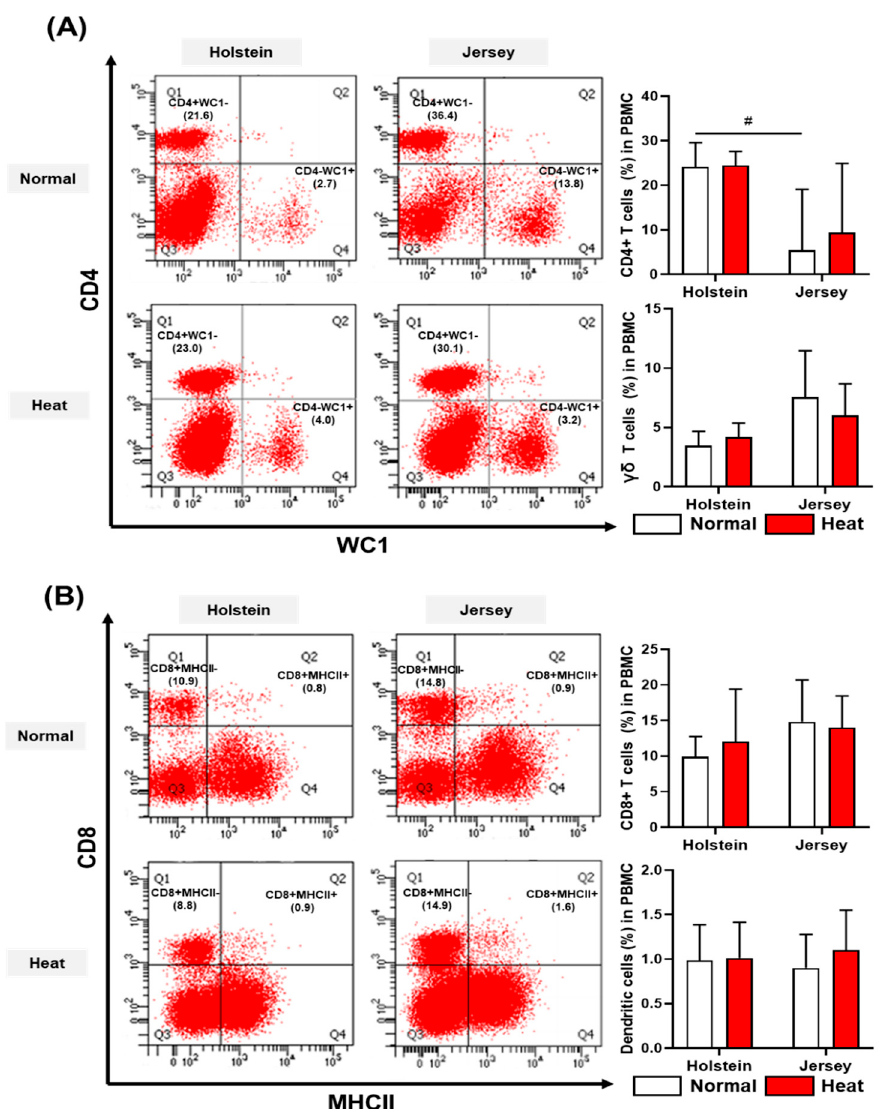
Figure 8. Alteration in blood T cells and dendritic cells in PBMCs from two breeds of dairy cow under different environmental conditions. The population of T cells and dendritic cells in Holstein and Jersey cows under normal and high-heat environmental conditions were analyzed using flow cytometry. The CD4 T cell (CD4+WC1–) and γδ T cell (CD4–WC1+) populations in PBMCs are presented in ( A ), and CD8 T cell (CD8+MHCII-) and dendritic cell (CD8+MHCII+) populations in PBMCs are shown in ( B ). Data are represented as means ± standard deviation (SD); n = 7–8 animals/group. Values were statistically analyzed by a mixed-effects model with Tukey’s multiple comparison test. # p <